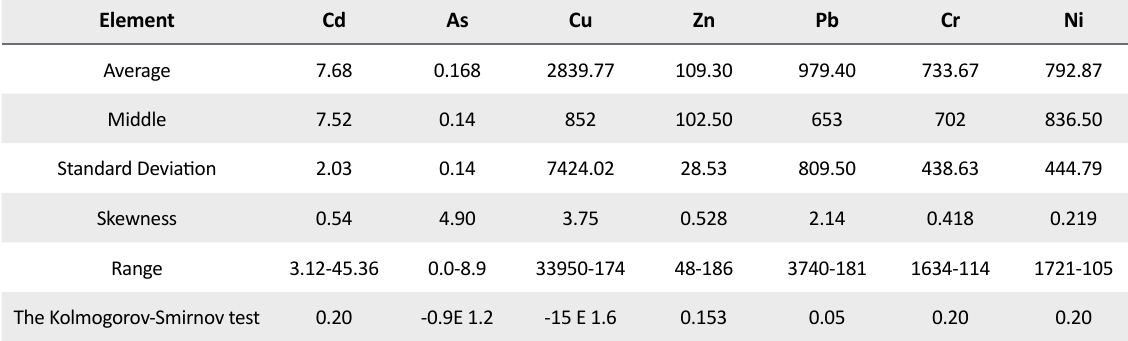
The Kolmogorov-Smirnov